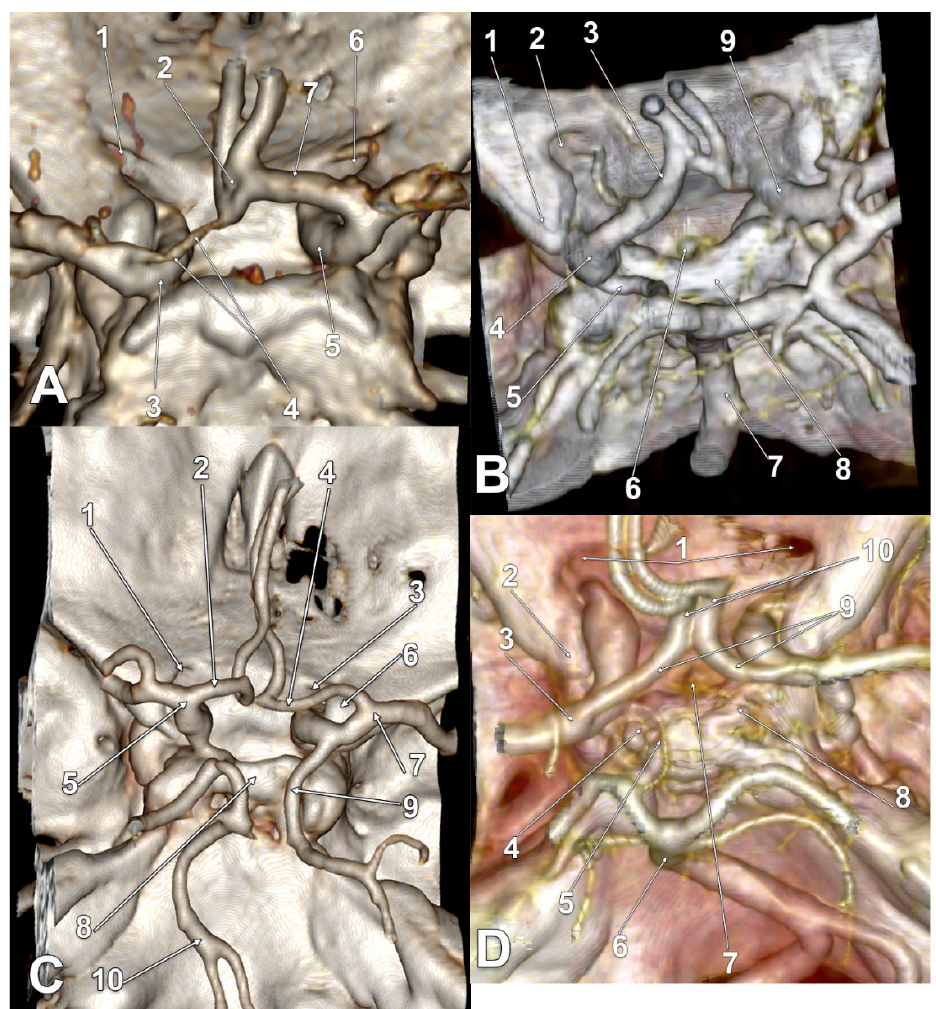
Figure 2. ( A ) Three-dimensional volume rendering of the skull base, posterosuperior view. Infraoptic, supracarotid and hypoplastic left anterior cerebral artery. 1. Left optic canal; 2. fenestrated anterior communicating artery; 3. left internal carotid artery; 4. A1 segment of the left anterior cerebral artery; 5. right internal carotid artery; 6. right optic canal; 7. A1 segment of the right anterior cerebral artery. ( B ) Three-dimensional volume rendering of the skull base, posterosuperior view. Bihemispheric infraoptic left anterior cerebral artery. 1. Left anterior clinoid process; 2. left optic canal; 3. bihemispheric left anterior cerebral artery; 4. left internal carotid artery bifurcation; 5. posterior communicating artery; 6. pituitary stalk; 7. basilar artery; 8. dorsum sellae; 9. right internal carotid artery. ( C ) Three-dimensional volume rendering of the skull base, posterosuperior view. Supraclinoid, infraoptic and supracarotid right anterior cerebral artery. 1. Left optic canal; 2. supraoptic A1 segment of the left anterior cerebral artery; 3. right optic canal; 4. infraoptic A1 segment of the right anterior cerebral artery; 5. left internal carotid artery bifurcation; 6. right anterior clinoid process; 7. right internal carotid artery bifurcation; 8. dorsum sellae; 9. fetal type of posterior cerebral artery; 10. basilar artery. ( D ) Three-dimensional volume rendering of the skull base, posterosuperior view. Posterolaterally displaced carotid bifurcations and resulting infrachiasmatic A1 segments of the anterior cerebral arteries. 1. Optic canals; 2. left anterior clinoid process; 3. left internal carotid artery bifurcation; 4. left posterior clinoid process; 5. left posterior communicating artery; 6. basilar artery; 7. pituitary stalk; 8. right posterior clinoid process; 9. A1 segments of the anterior cerebral arteries; 10. prechiasmatic loops of the A2 segments of the anterior cerebral arteries.